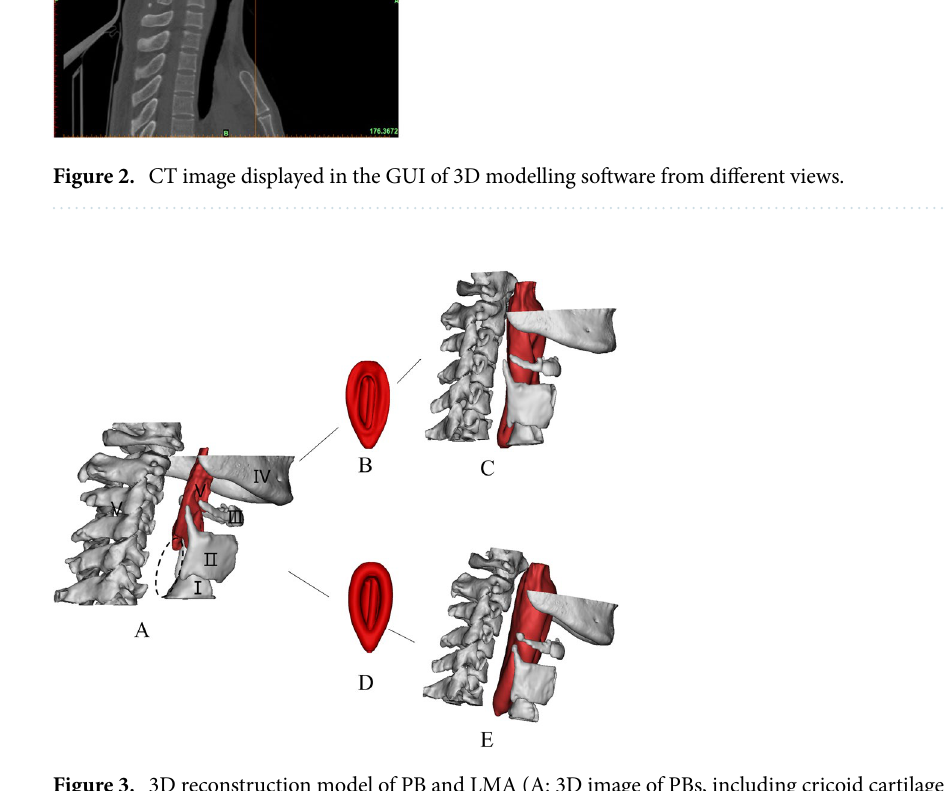
Figure 3. 3D reconstruction model of PB and LMA (A: 3D image of PBs, including cricoid cartilage (I), thyroid cartilage (II), hyoid bone (III), mandible (IV), spine (V), B: LMA50; C: 3D image of PB-LMA50; D: LMA100; E: 3D image of PB-LMA100. The position indicated by the elliptical dotted line is the closed